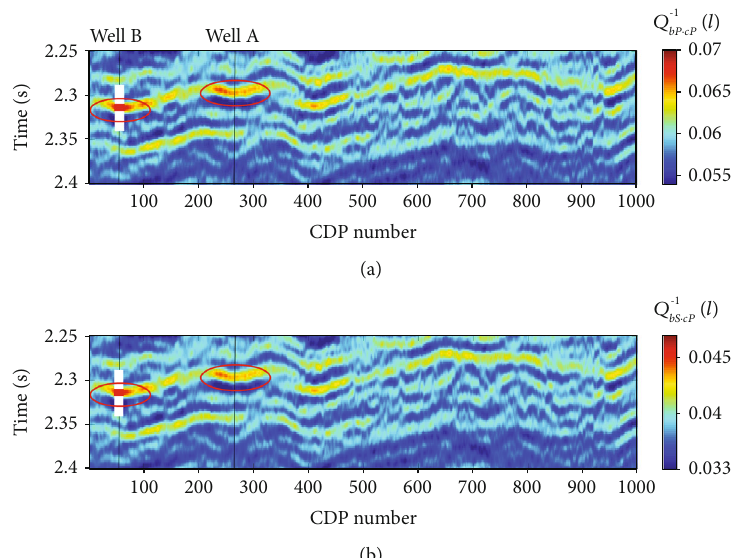
Figure 12: Estimated attenuation parameters, where (a) is the P-wave attenuation parameter and (b) is the S-wave attenuation